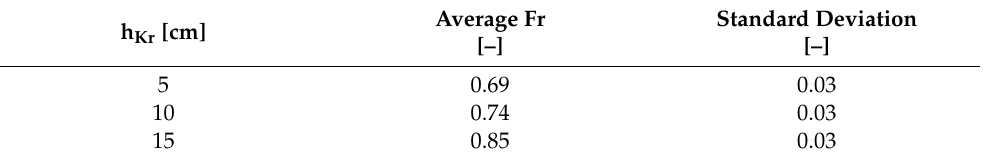
Table 3. Average Froude number for each initial height and associated standard